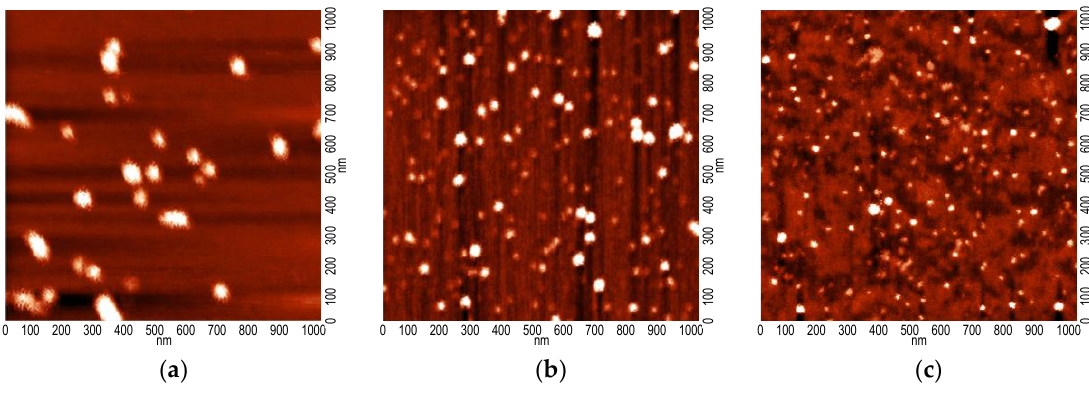
Figure 3. AFM topography images of Ru suspensions in PDDA solutions used for intercalation of ( a ) Mt/(Ru + PDDA_0.01); ( b ) Mt/(Ru + PDDA_0.05); and ( c ) Mt/(Ru + PDDA_0.25) samples.